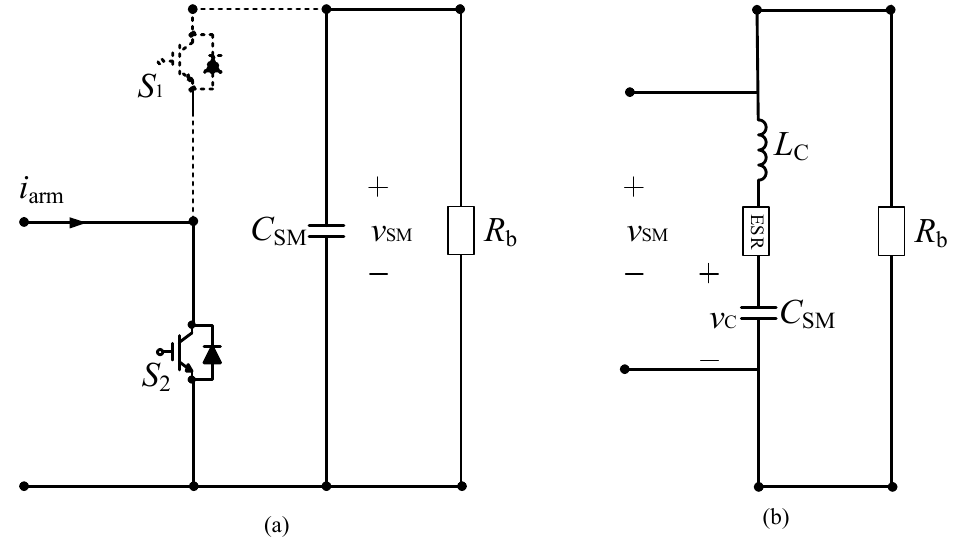
Figure 14. Operation circuits of an submodule (SM) ( a ) resistor-capacitor ( RC ) discharging circuit; ( b ) equivalent circuit in discharging mode.